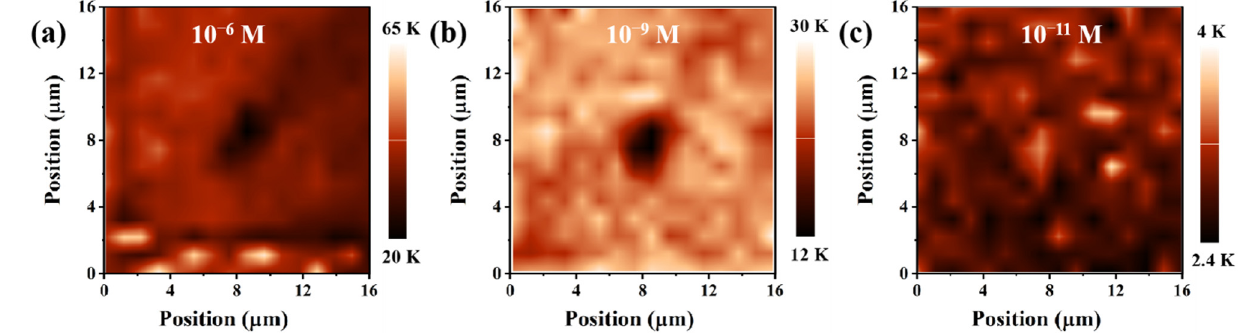
Figure 6. The integral intensity mapping image of ( a ) 10 − 6 , ( b ) 10 − 9 and ( c ) 10 − 11 M R6G solution at peak 612 cm − 1 (595–625 cm − 1 ). peak 612 cm − 1 (595–625 cm − 1